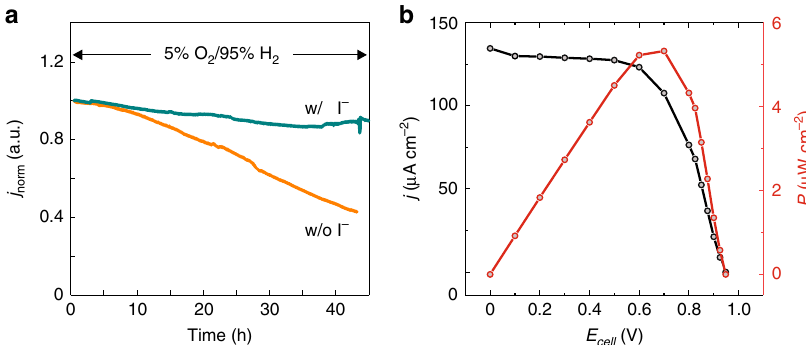
Fig. 5 Turnover stability of viologen-modi fi ed fi lms containing hydrogenase. a The catalytic current densities for H 2 oxidation in the presence of 5% O 2 are normalized ( j norm ) by their maximum values. The measurements are performed in phosphate buffer (0.1 M, pH 7) in the absence or in the presence